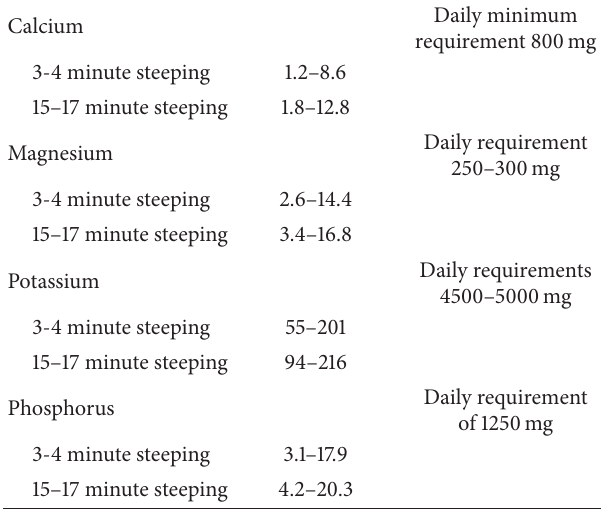
Table 1: Healthy minerals found in teas in this study